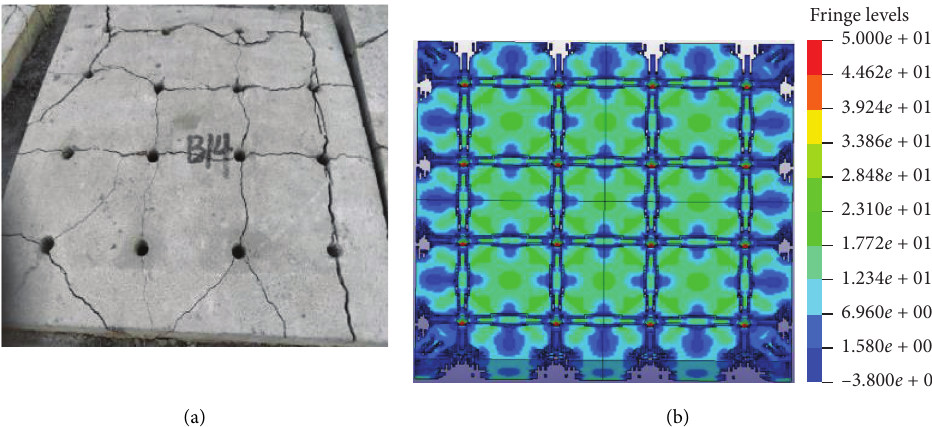
Figure 6: Comparison of experimental results and simulation results for a concrete slab. (a) The test result. (b) The simulation result.